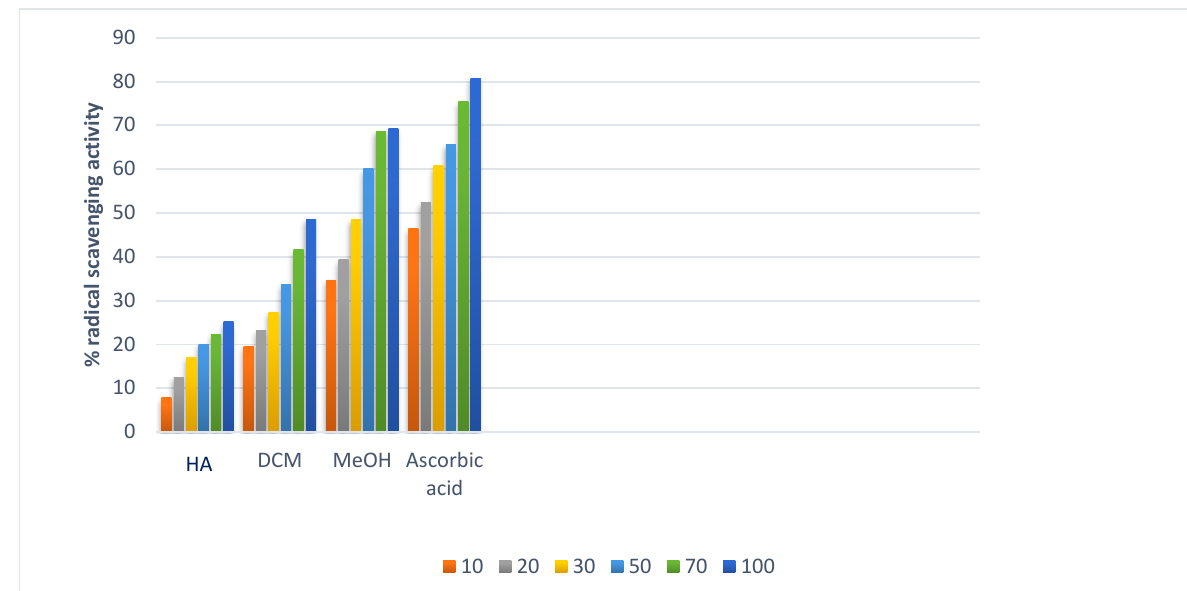
Figure 7. Reducing power of extracts of N. mexicana Zucc.